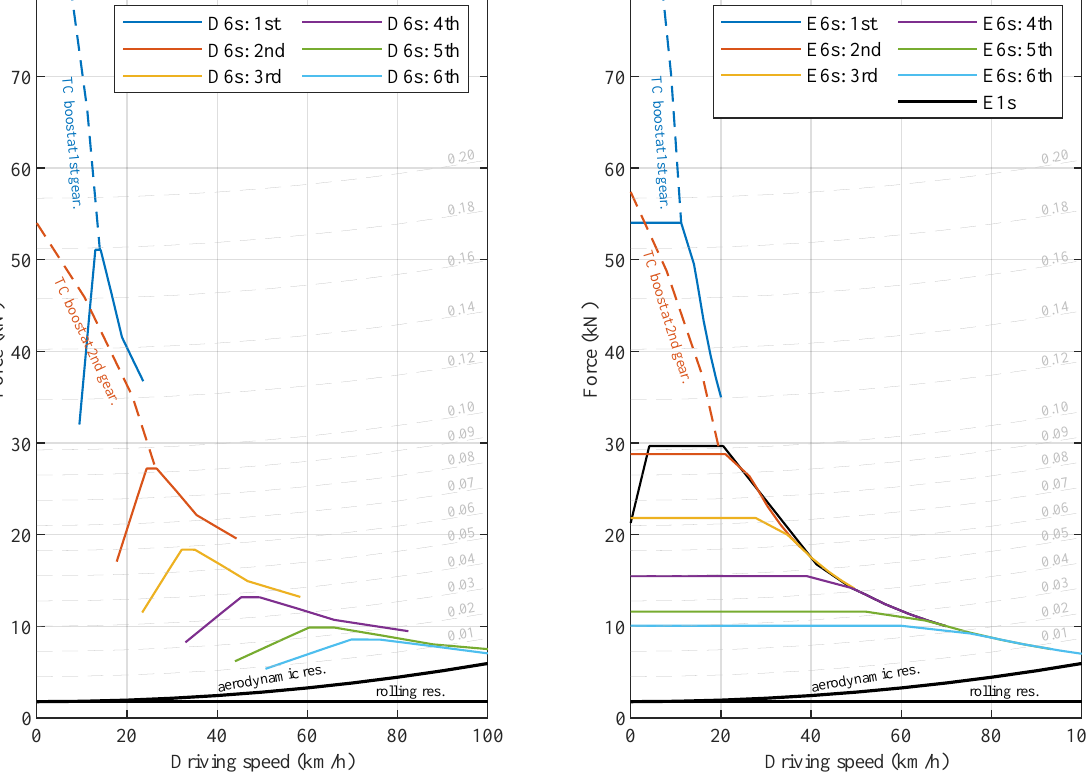
Figure 7. Tractive force curves for the diesel (on the left) and electric (on the right) powertrains. The grey dashed lines represent road slopes in per cent whereas the solid coloured lines show the tractive forces in each gear. The blue and red dashed lines represent the available maximum torque when the converter is unlocked in the first and second gear,